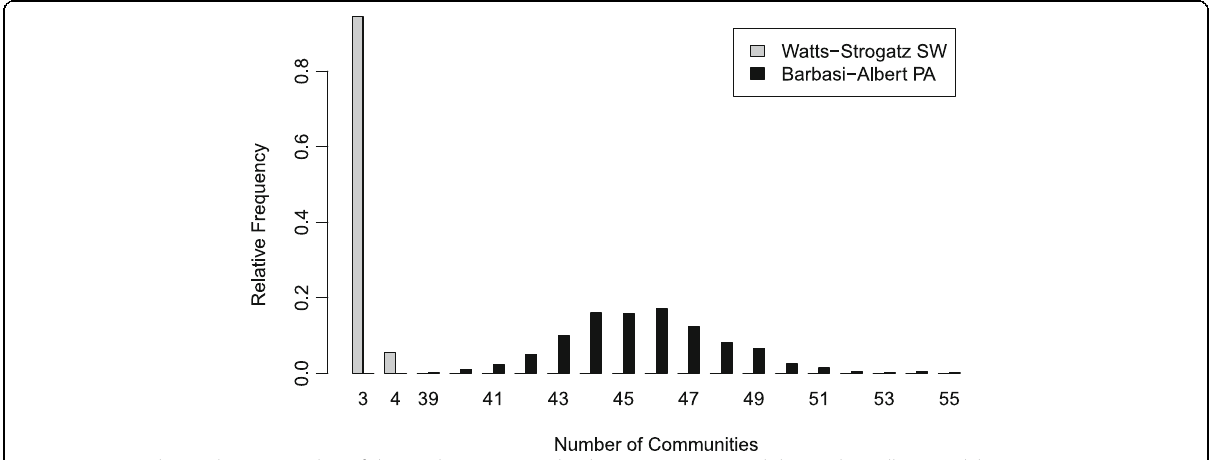
Fig. 5 Monte-Carlo simulations: Number of detected communities by the Watts-Strogatz and the Barabási-Albert